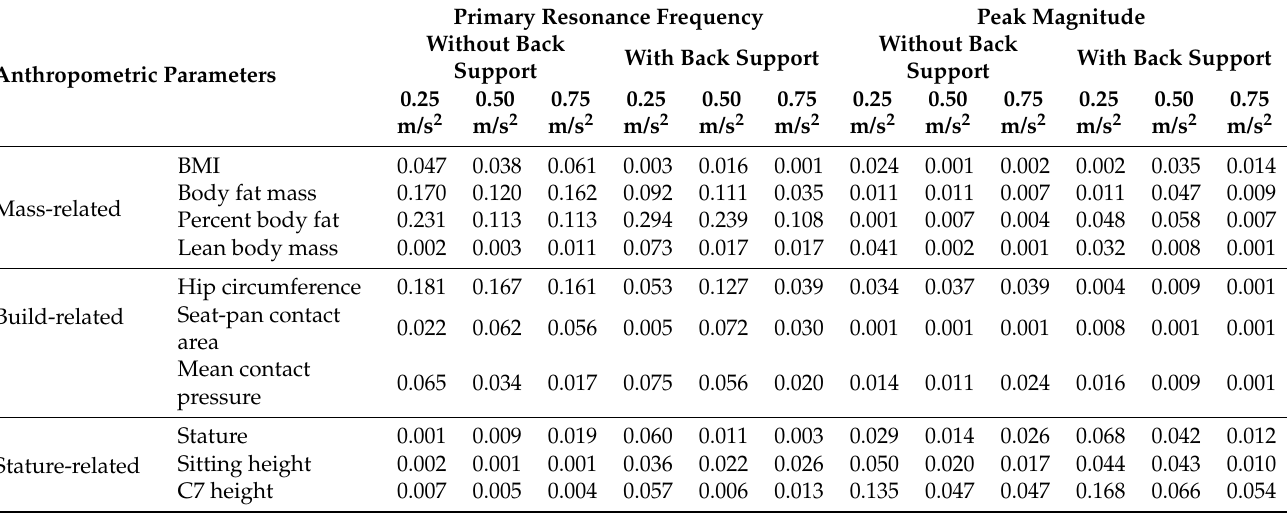
Table 7. Values of r 2 between anthropometric parameters and the peak vertical STHT magnitude, as well as primary resonance frequency, for three excitations and two sitting conditions for seat